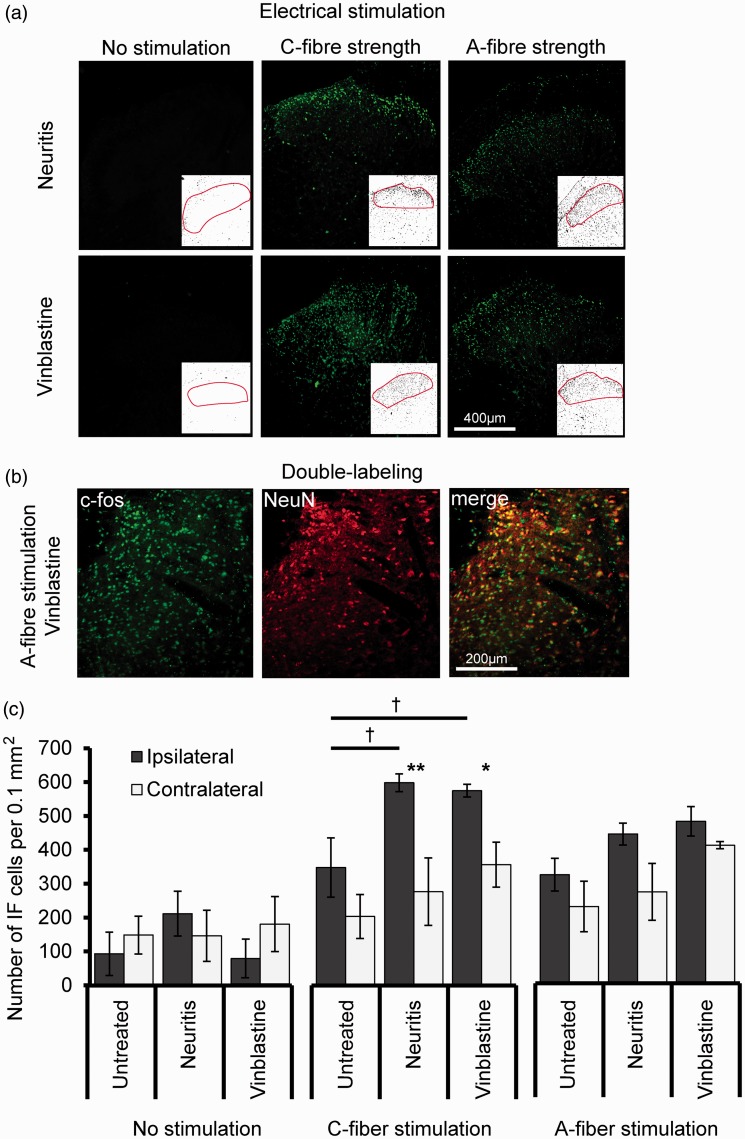
Electrical stimulation-activated c-Fos expression in the L5 dorsal horn. (a) Example images of c-Fos expression (green staining) in the ipsilateral dorsal horn following neuritis and vinblastine treatment. Prior to removal of the tissue, animals received either 5-min repeated stimulation of the sciatic nerve at C- (middle) or A-fiber strength (right), or no stimulation (left). The majority of c-Fos positive cells were located in the superficial laminae. Note inserts that represent the respective image thresholding used for ImageJ analysis. (b) Colocalization of c-Fos (green) with NeuN (red). (c) Mean number of c-Fos positive cells per 0.1 mm2 in each group (n = 4 animals in each group). †p < 0.05, comparing between treatments; *p < 0.05, **p < 0.01 comparing between sides (two-way ANOVA followed by Bonferroni’s post hoc tests). Error bars = SEM.IF: Immunofluorescent; SEM: standard error of the mean.